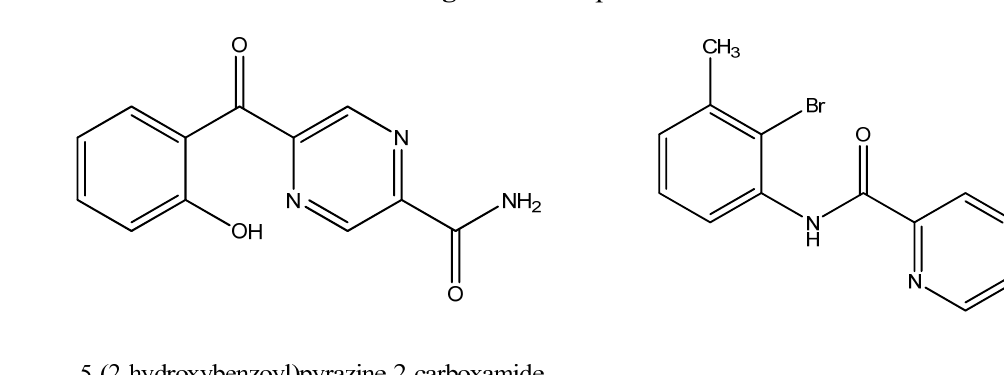
Figure 1. Compounds I and II